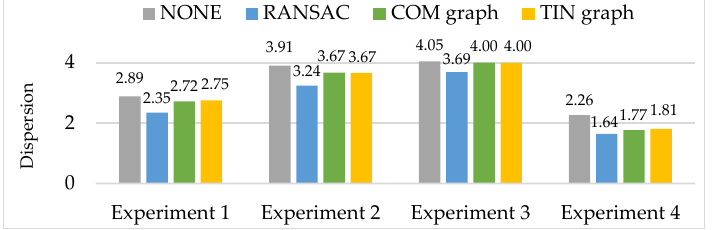
Figure 10. Experimental results of dispersion D .